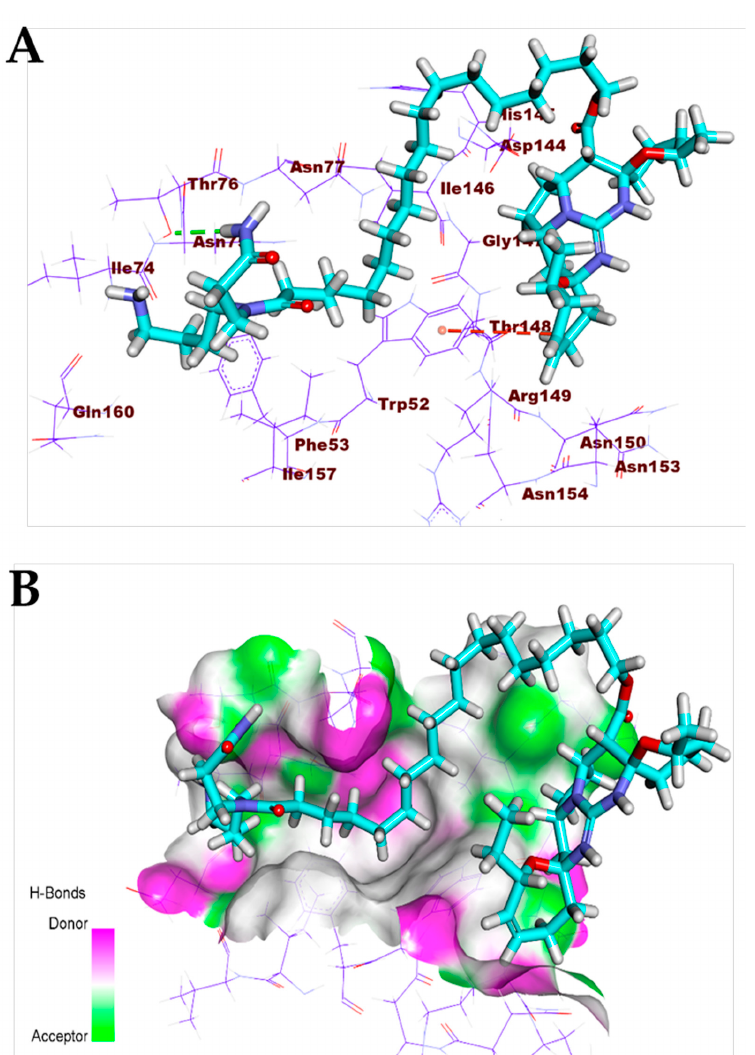
Figure 13. ( A ) Compound 13 docked into the active site of COVID-19 nucleocapsid phosphoprotein. ( B ) Mapping surface showing compound 13 occupying the active pocket of COVID-19 nucleocapsid phosphoprotein.